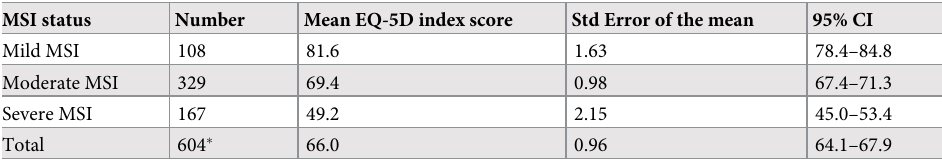
Table 5. Impact of MSI on quality of